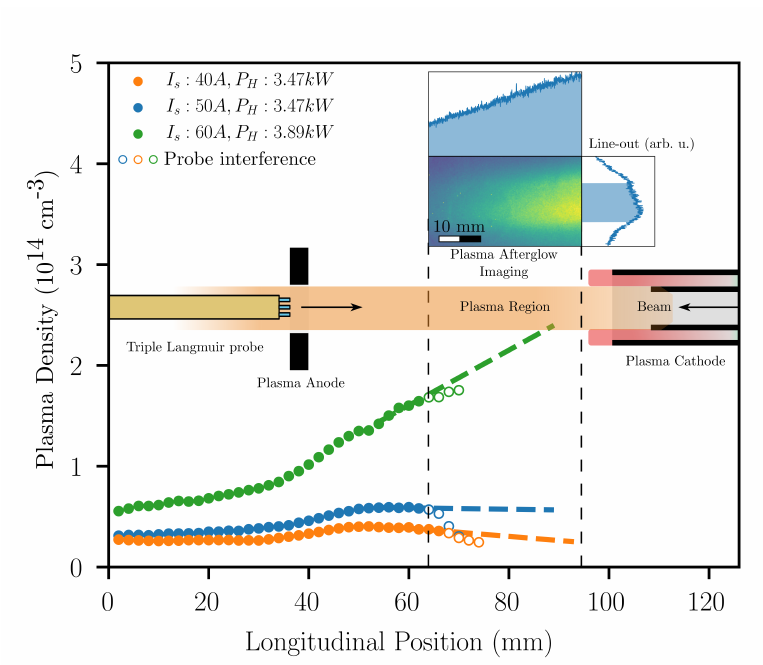
Figure 4. Longitudinal plasma density profile characterization as a function of solenoid current I s and heating power delivered to cathode tubes P H with a cartoon of source geometry and diagnostics properly scaled in the longitudinal direction. Hollow points represent measurements affected by probe interference in the plasma discharge. The unaffected profile is extrapolated (dashed lines) using a linear relation, inferred from a measurement of the corresponding plasma afterglow brightness (inset). Imaging also shows a root-mean-squared plasma column width of 8